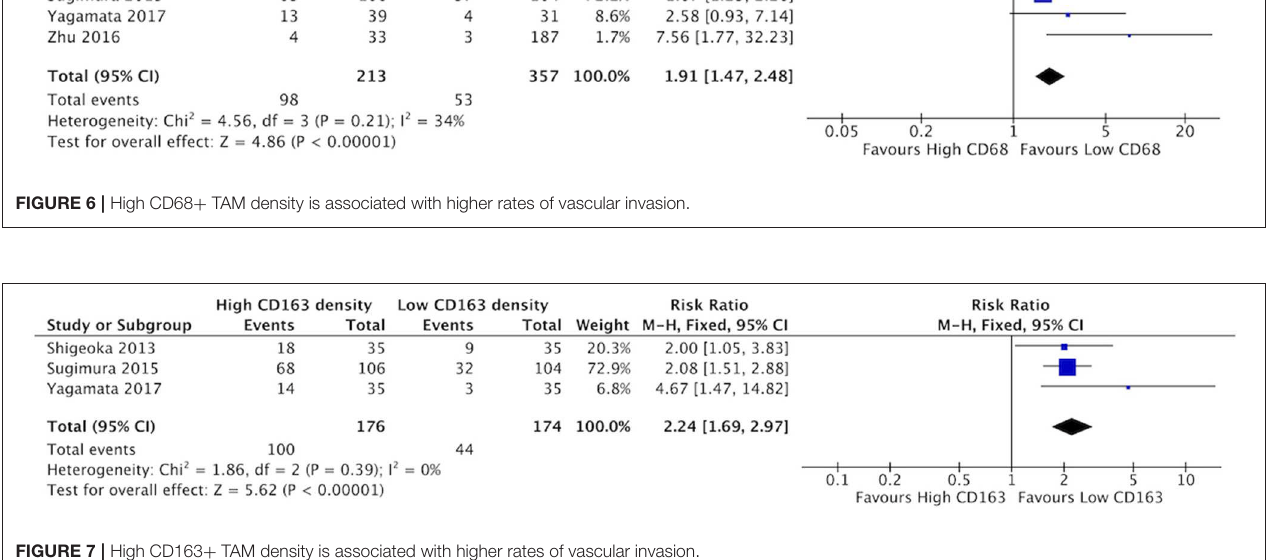
Frontiers in Oncology | www.frontiersin.org